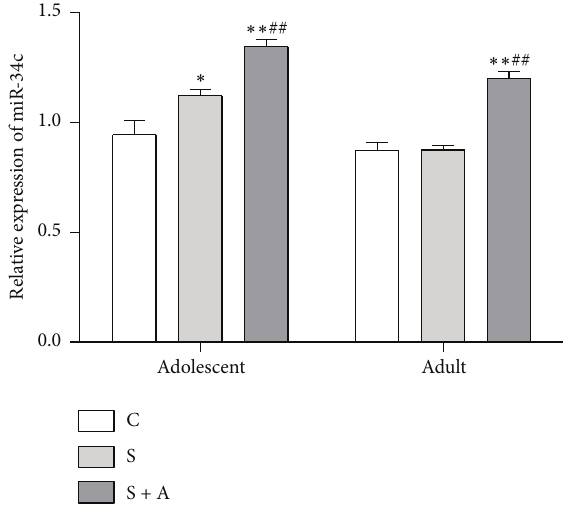
Figure 6: Relative expression of miR-34c in adolescent and adult hypothalamus. Values were expressed as mean ± SEM. ∗ and ∗∗ indicate 𝑝 < 0.05 and 𝑝 < 0.01 versus CON, respectively; # indicates 𝑝 < 0.05 versus